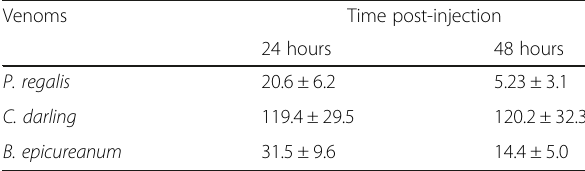
Table 1 LD 50 values estimated from injection of P. regalis , C. darlingi , and B. epicureanum venoms into crickets Venoms